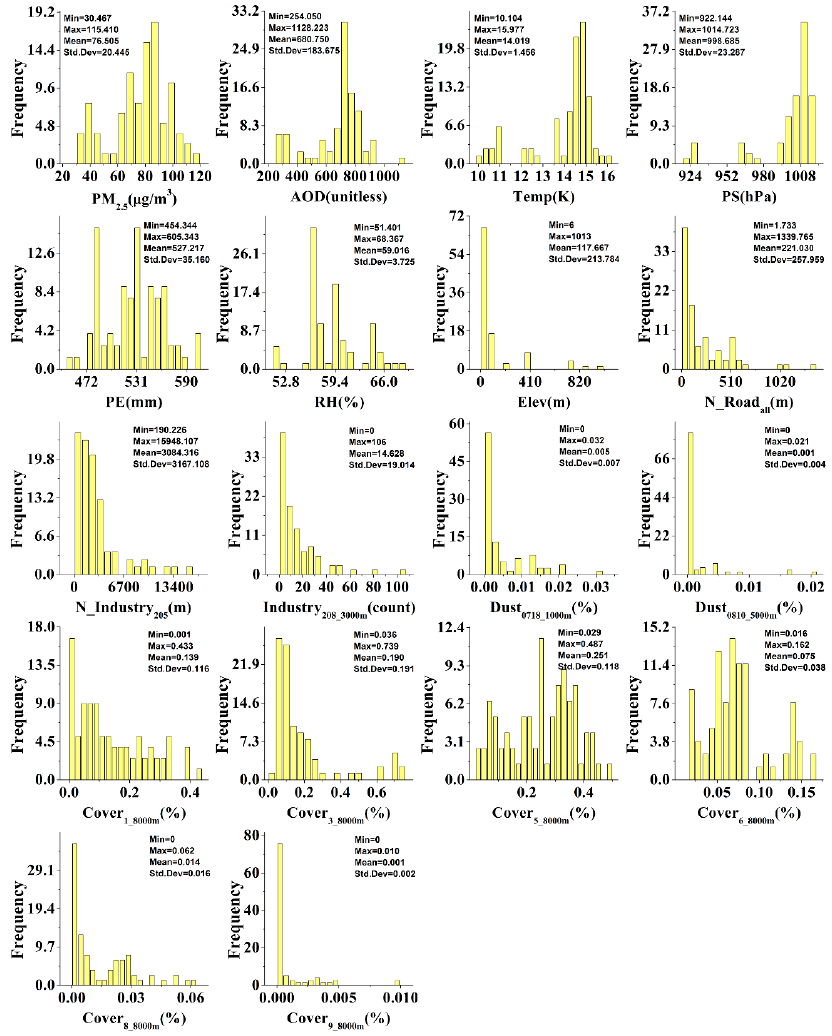
Figure 3. Histogram and description of PM 2.5 concentrations and potential predictor variables.